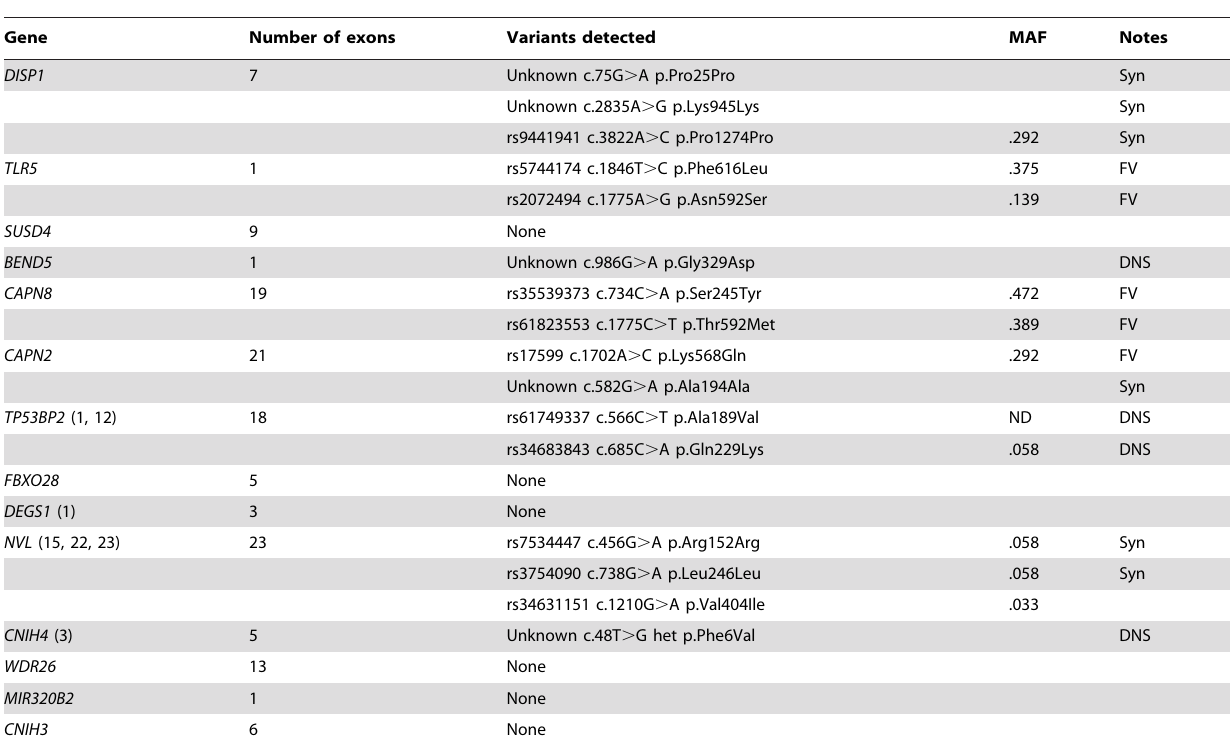
Table 2. Variants detected by Sanger sequencing in two affected